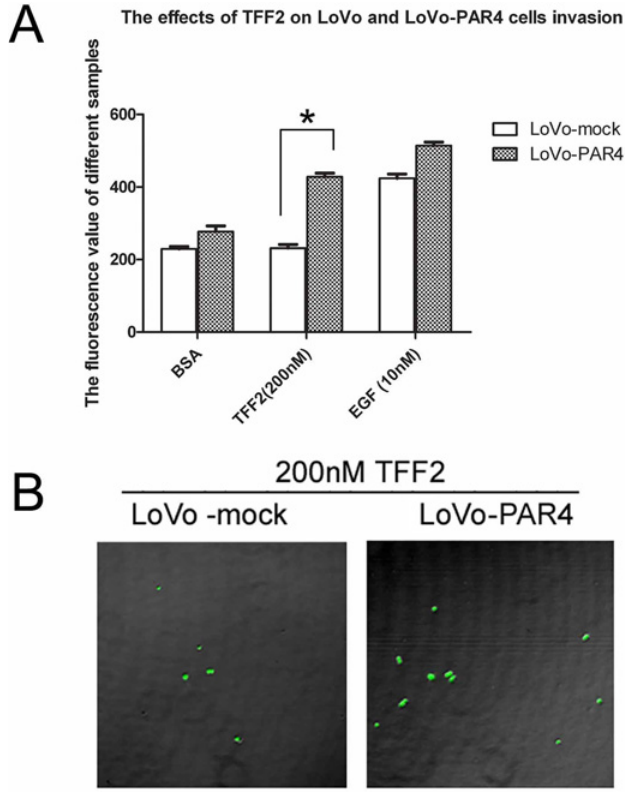
Fig 4. Effect of recombinant TFF2 on the invasion of LoVo-mock and LoVo-PAR4 cells. (A) Cell invasion stimulated by TFF2 was tested using an InnoCyte cell invasion assay. Invasion of LoVo-mock and LoVo-PAR4 cells stimulated by 200nM TFF2 was tested, with BSA and 10nM EGF as controls. The results showed significant difference of 200nM TFF2 on LoVo-mock and LoVo-PAR4 cells invasion activity. Data were presented as means ± SD of three independent experiments. * p < 0.05; (B) Invasion of LoVo-mock and LoVo-PAR4 cells stimulated by 200nM TFF2 were investigated by Confnocal laser fluorescence